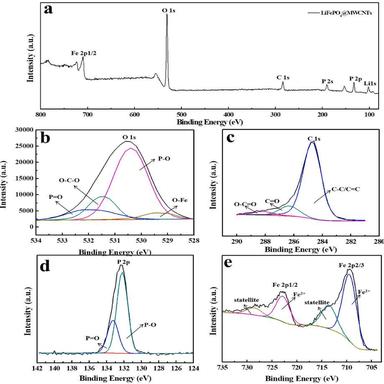
XPS curves of LiFePO4@MWCNTs (a); O 1s (b); C 1s (c); P 2p (d); Fe 2p (e) in LiFePO4@MWCNTs.